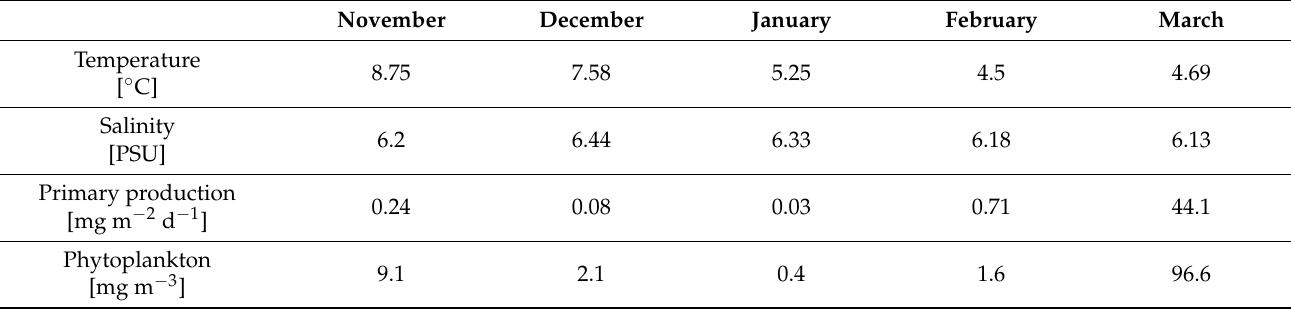
Table 1. Parameters of seawater sampled from Gdynia station, located in the coastal waters of